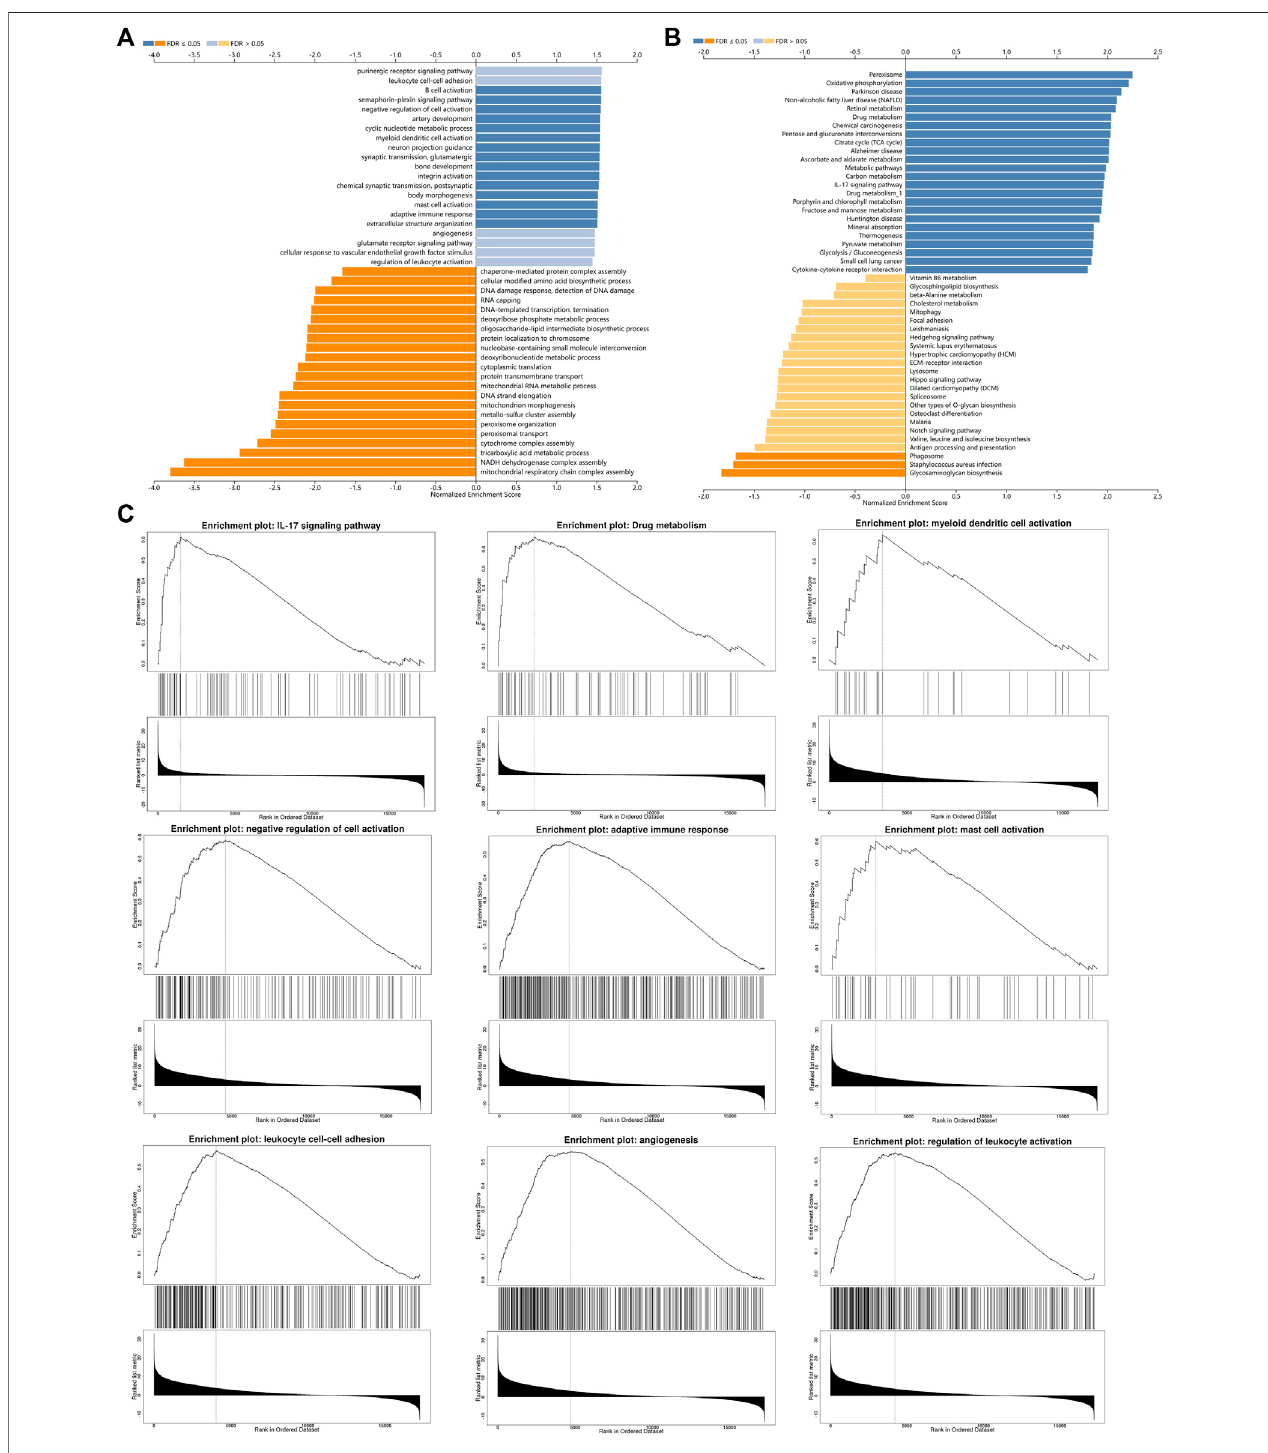
FIGURE 6 | GO (A) and KEGG (B) pathway analyses from LinkOmics. (C) Immune-related biological processes and pathways that related to INSC in COAD.